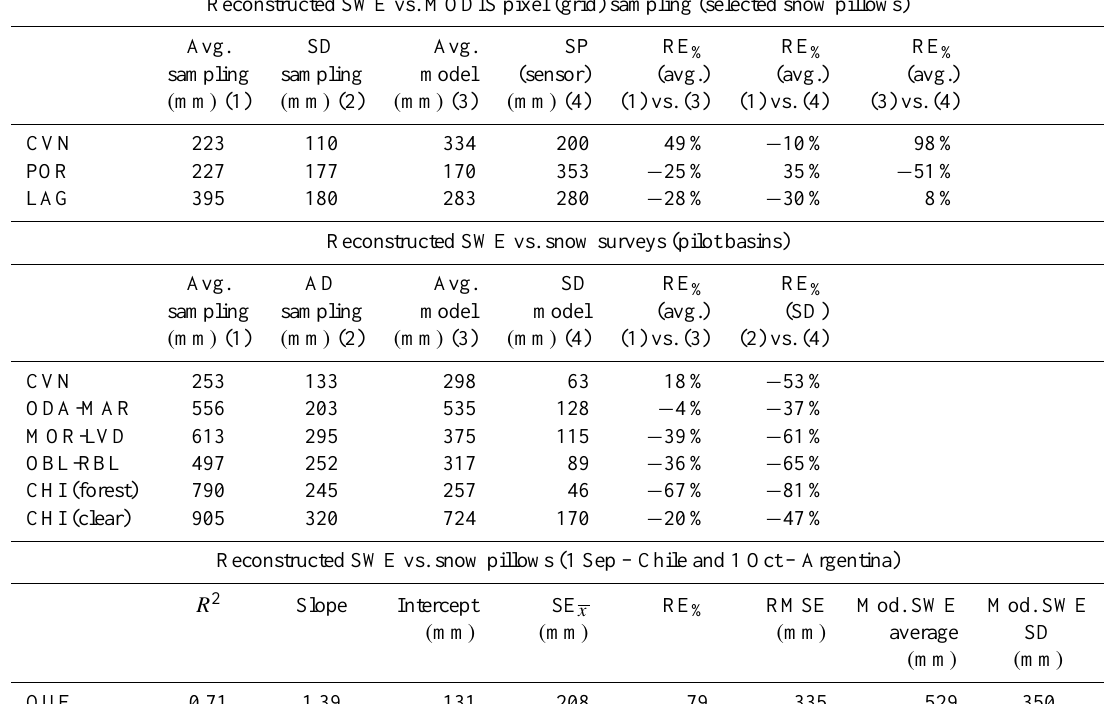
Table 4. Model validation statistics against intensive study area observations around snow pillows and at catchment scale. Reconstructed SWE vs. MODIS pixel (grid) sampling (selected snow pillows) Avg. Avg.